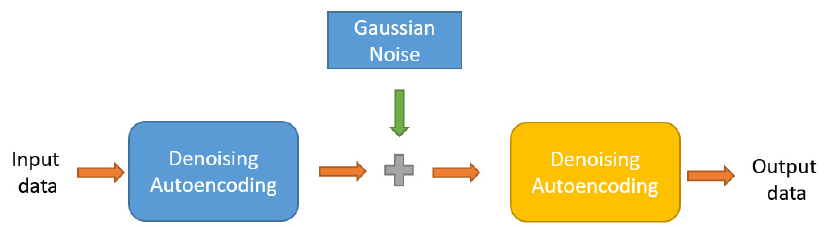
Figure 1. Flowchart of proposed Data Washing algorithm.